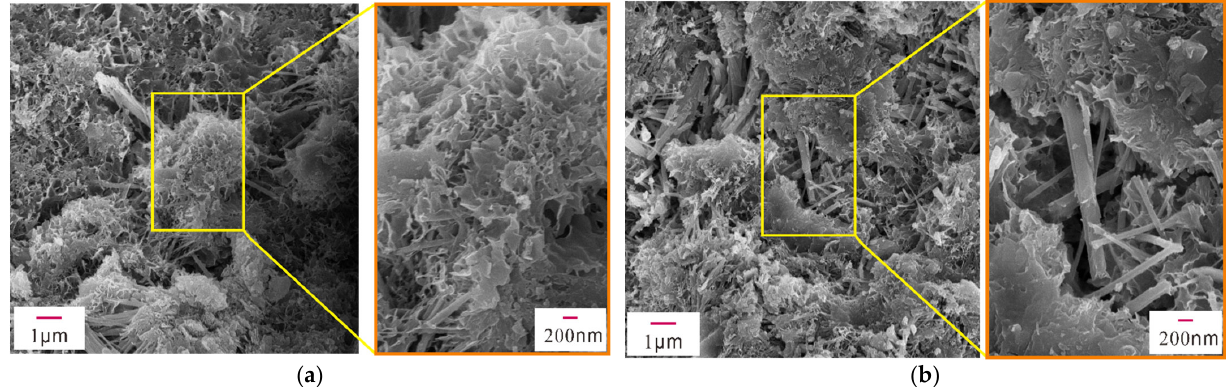
Figure 5. SEM images of sample Q. ( a ) Partial SEM image of sample Q, ( b ) Partial SEM image of sample Q.